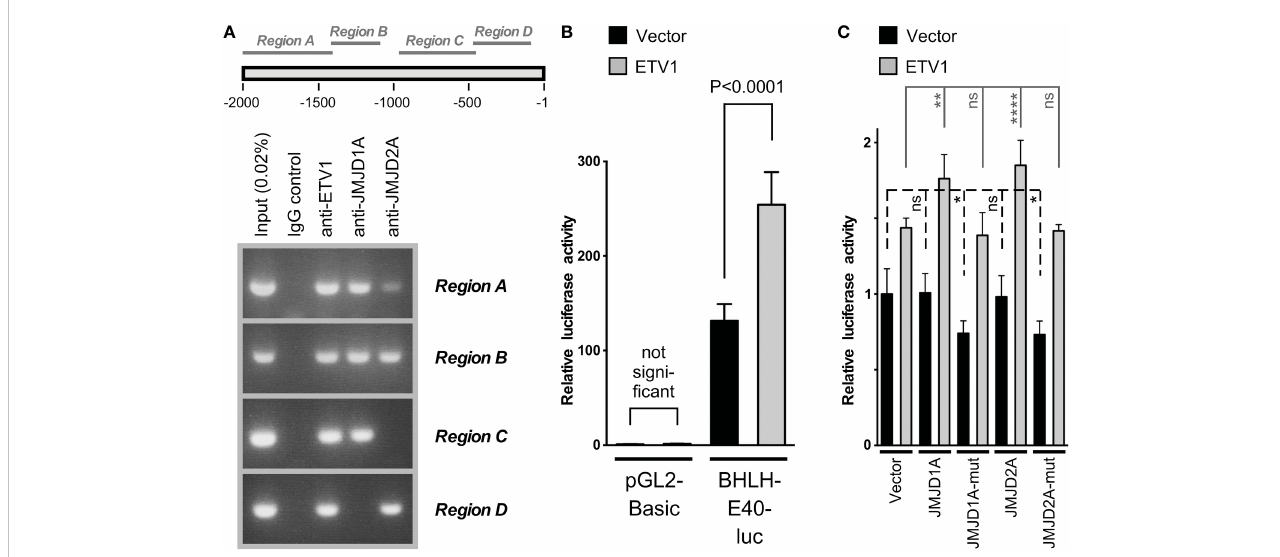
FIGURE 2 Analysis of the BHLHE40 gene promoter in HCT116 cells. (A) Chromatin immunoprecipitation assay. Four different regions (see scheme on top) of the BHLHE40 promoter were ampli fi ed after immunoprecipitation with indicated antibodies. (B) Activation of the (-2000/+50) BHLHE40 promoter luciferase reporter construct or the parental vector pGL2-Basic upon ETV1 overexpression. Shown are means with standard deviations (n=4). One-way ANOVA with post hoc Tukey ’ s multiple comparisons test. (C) Similar, joint stimulation of the (-2000/+50) BHLHE40 promoter luciferase activity by ETV1 and either JMJD1A or JMJD2A; “ mut ” indicates catalytically inactive mutants of JMJD1A (H1120A/D1122G) or JMJD2A (H188A). Shown are means with standard deviations (n=6). Statistical signi fi cance was determined by one-way ANOVA with post hoc Tukey ’ s multiple comparisons test. *P < 0.05; **P < 0.01; ****P < 0.0001; ns, not signi fi